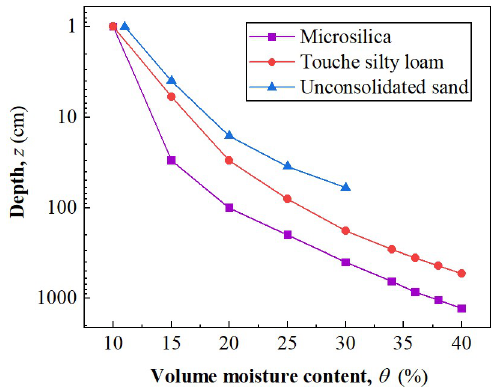
Figure 7. Relationship between volumetric moisture content and buried depth.